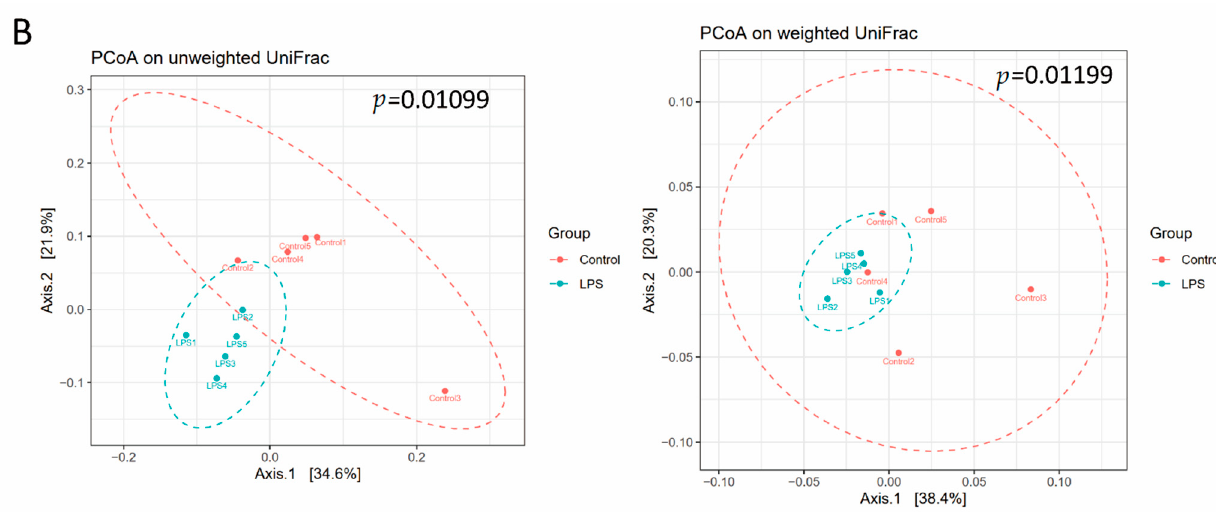
Figure 2. Fecal microbiome distribution in male maternal immune activation (MIA) offspring. The feces of prenatal lipopolysaccharide (LPS)-stimulated male offspring (LPS group) and control rats were prepared for fecal microbiome profiling through high-throughput sequencing of the 16s rRNA gene on the Illumina MiSeq system. ( A ) Alpha diversity of MIA offspring (LPS) and controls. ( B ) Principal coordinate analysis plot based on unweighted or weighted UniFrac distance of omeprazole MIA offspring and control samples. A significant difference in beta diversity was evaluated using permutational multivariate analysis of variance (vegan:adonis, 1000 permutations), and beta dispersion was quantified using a betadisper (vegan:betadisper, 1000 permutations). Both indices achieved adonis p < 0.05 and betadisper p > 0.05.